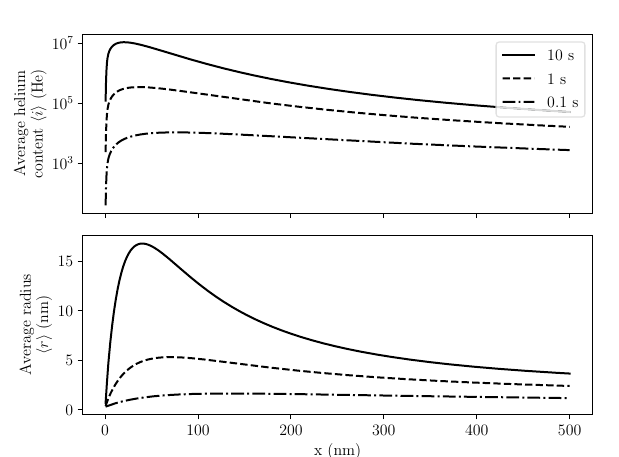
i and average radius (cid:31) (cid:30)